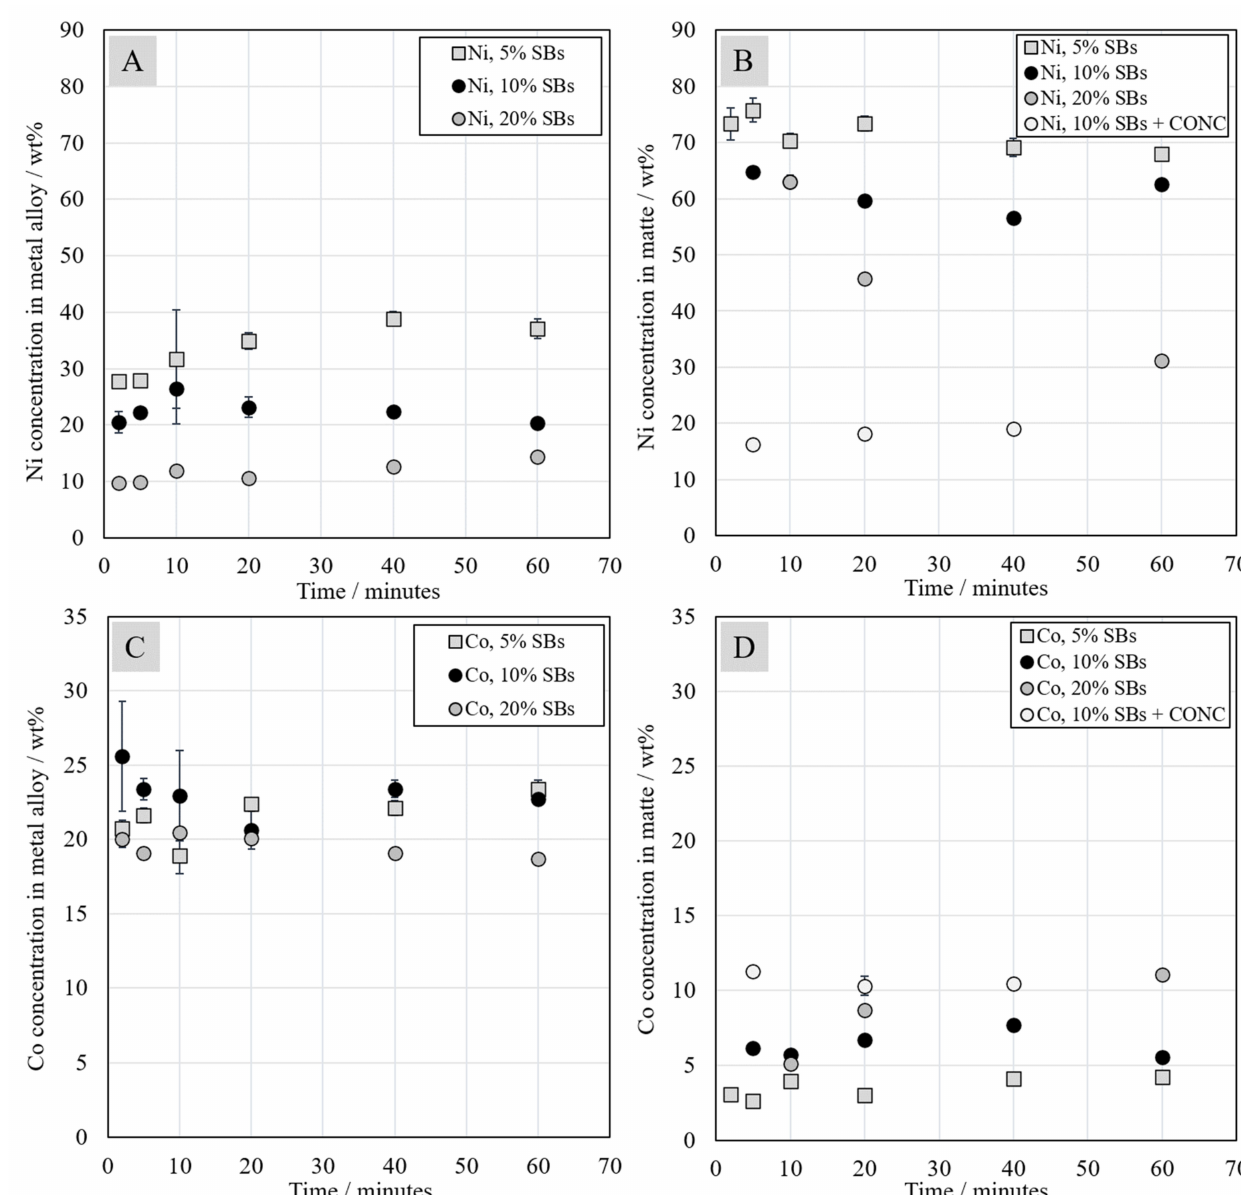
Figure 10. Concentrations of nickel ( A , B ) and cobalt ( C , D ) in the metal alloy and in the matte as a function of contact